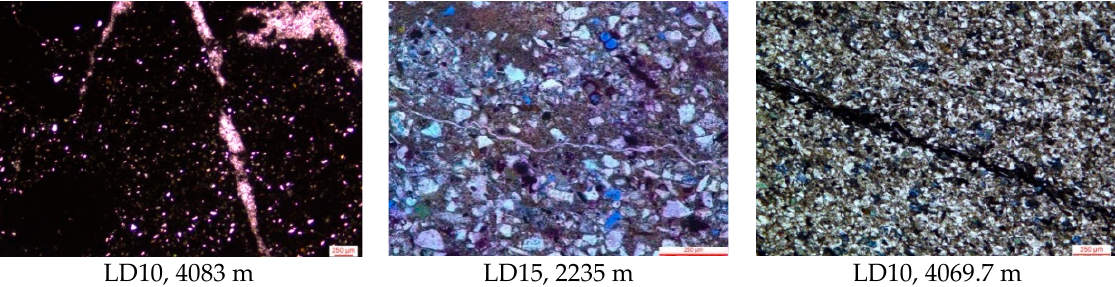
Figure 6. The coherence values of the collapse diapir in the study area.